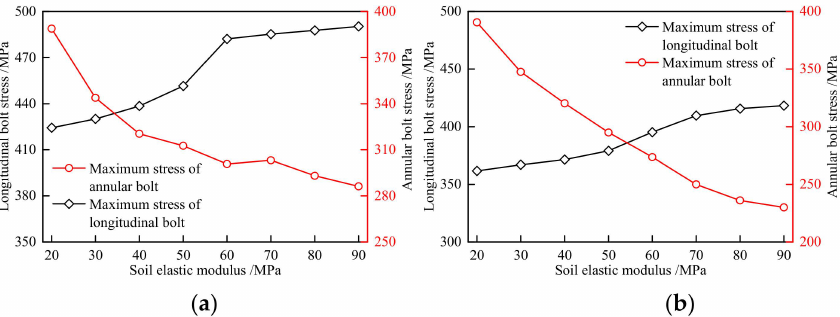
Figure 18. Effect of the elastic modulus of stratum on the maximum stress of joint bolts: ( a ) normal faulting condition and ( b ) reverse faulting condition.